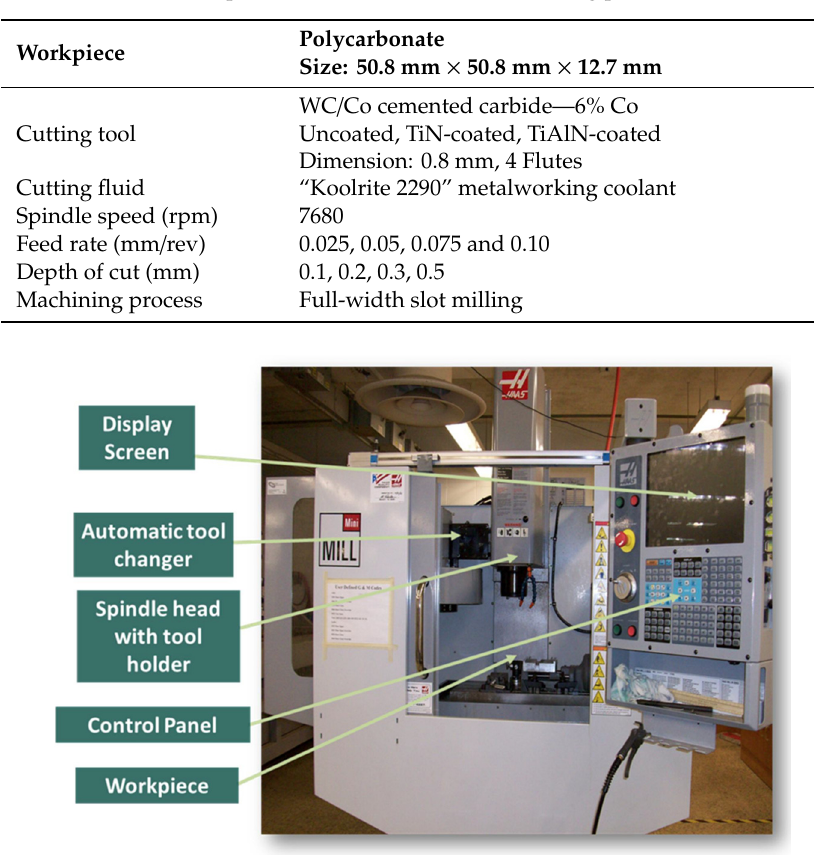
Table 1. Experimental conditions and machining parameters.